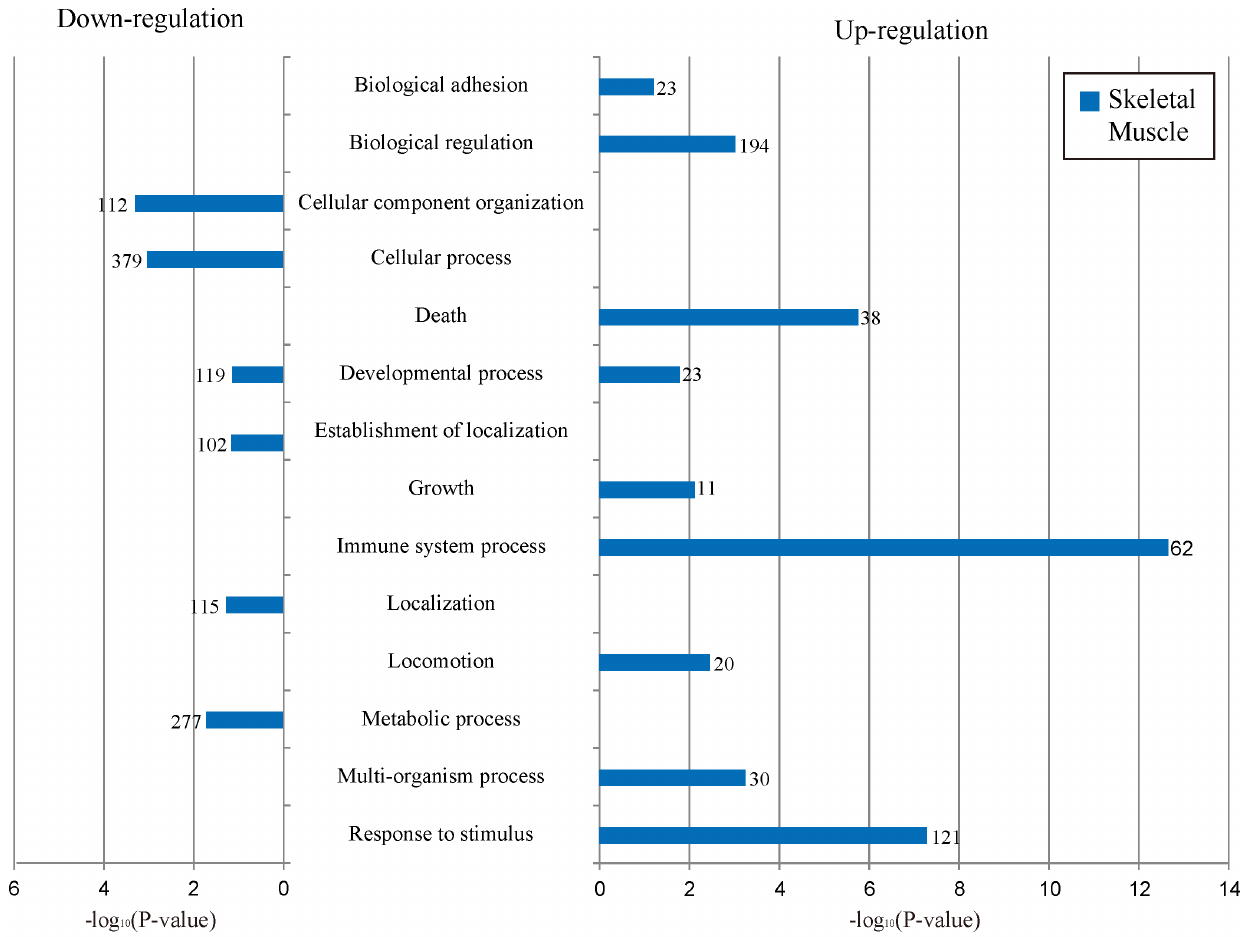
Figure 2. Biological process GO terms of tissues specific DEGs between before and after exercise in Thoroughbred. Up–regulated genes indicate higher activation after exercise than before and down-regulation genes indicate lower activation after exercise than before exercise.